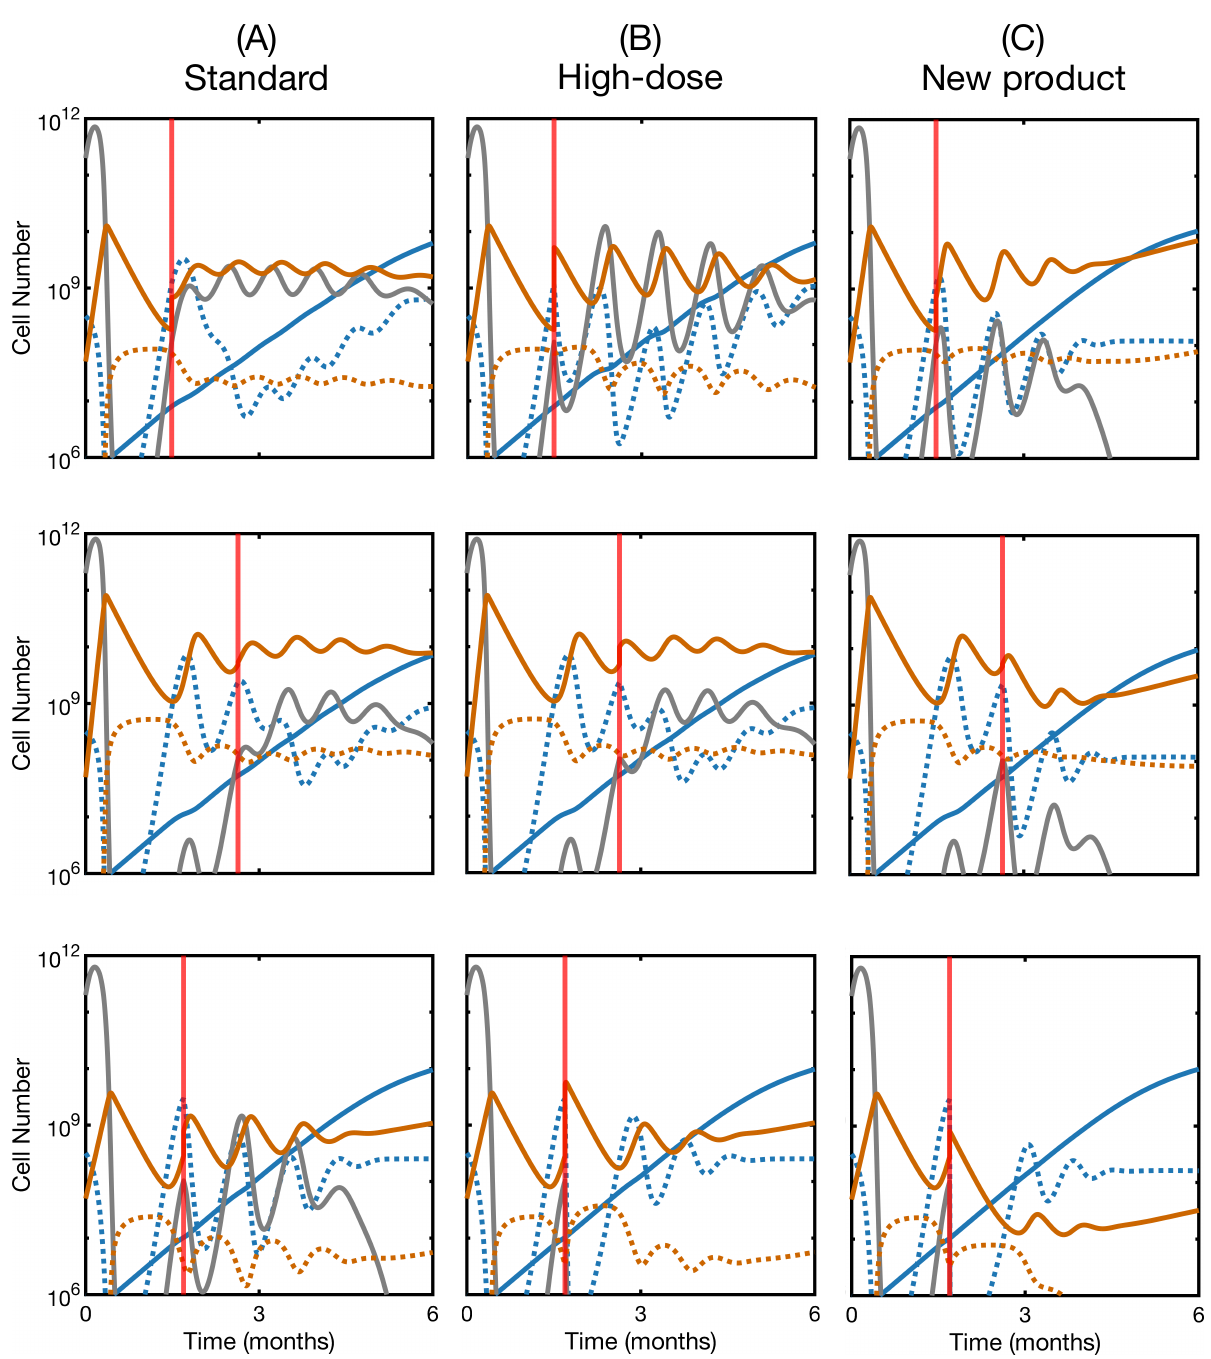
Figure 8. Effect of a second infusion of CAR T-cells in non-responding patients. Dynamics of leukemic cells, B cells and CAR T-cells for the three non-responding patients in Figure 6. ( A ) standard second dose of 5 × 10 8 CAR T-cells; ( B ) increased second dose of 5 × 10 9 CAR T-cells; ( C ) second dose of 5 × 10 8 CAR T-cells of a newly-manufactured product with improved attributes. For the first patient, the new attributes were h = 5 × 10 8 and ρ C = 0.9. For the second patient, the new attributes were h = 5 × 10 8 and α = 6 × 10 − 10 . For the third patient, the new parameters were α = 5 × 10 − 8 and ρ C = 0.7. We show activated and memory CAR T-cells (solid and dotted orange line, respectively), leukemic cells (solid gray line) and CD19 − and CD19 + B cells (solid and dotted blue lines, respectively). The red vertical line represents the time of the second infusion. The initial state for the simulations and the other parameter values were as in Figure